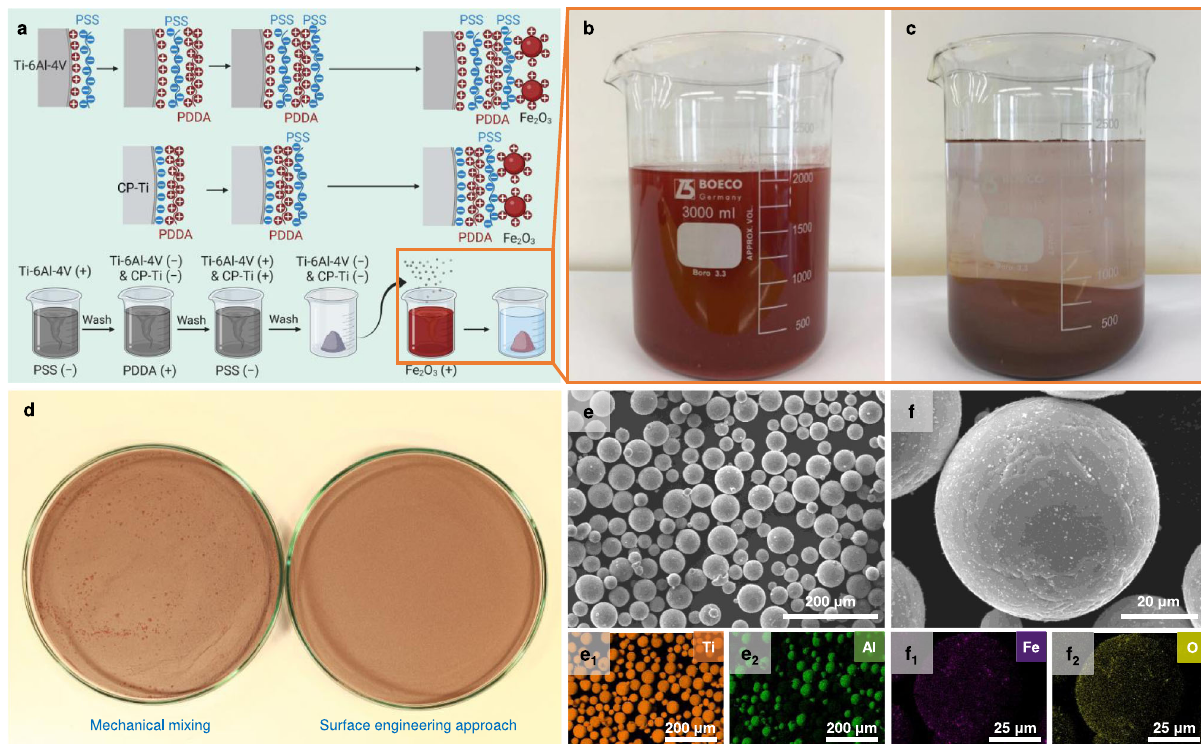
Fig. 2 | Feedstock preparation and characterization. a Schematic of the feed- stock preparation process via the surface engineering approach (Methods). Here, PSS and PDDA are poly(sodium 4-styrene sulfonate) and poly (diallyldimethylammonium chloride), respectively. The schematic diagram was createdwithBioRender.com. b , c TheFe 2 O 3 suspensionbefore( b )andafter( c )the